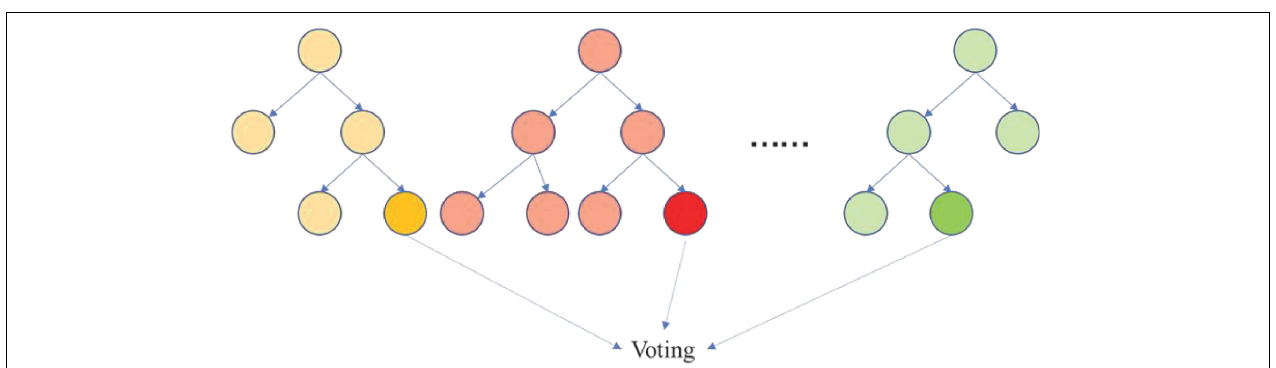
FIGURE 7 | Random forest. The iris color spectrum is defined as the vector in which the five probabilities ( [ p 1 , p 2 , p 3 , p 4 , p 5 ] ) correspond to the five grades of the color of the